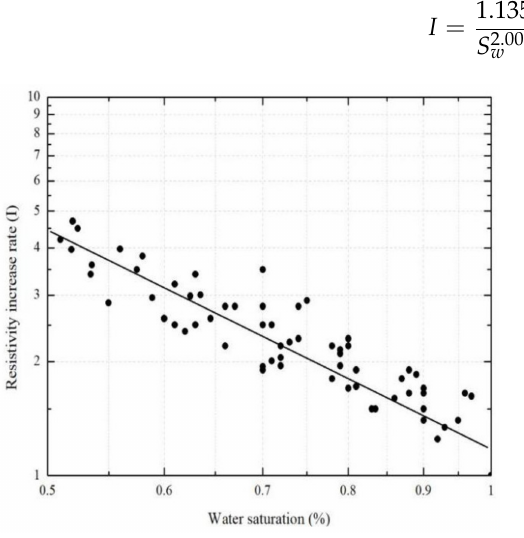
Figure 5. Water saturation and resistivity increase rate intersection